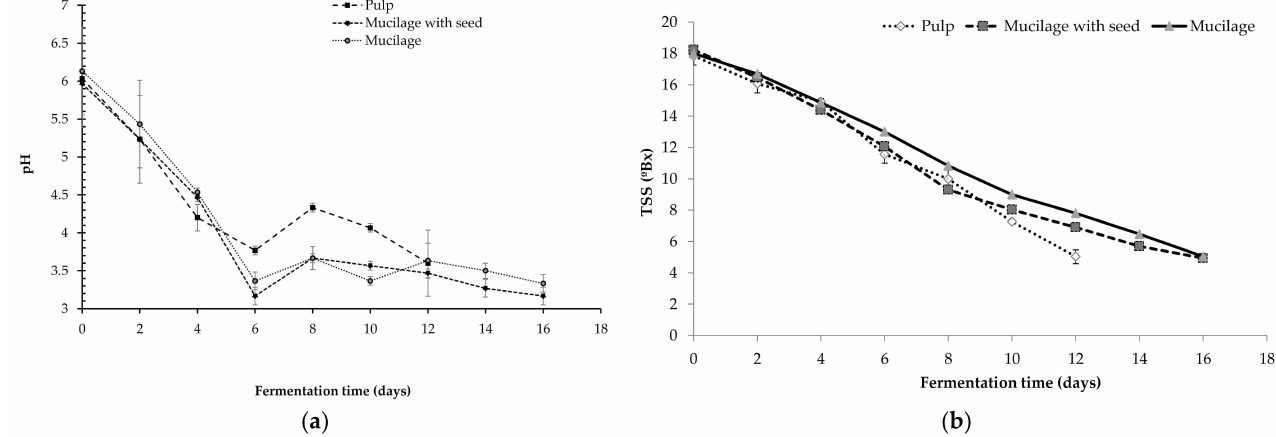
Figure 2. Changes during fermentation period. ( a ) pH. ( b )